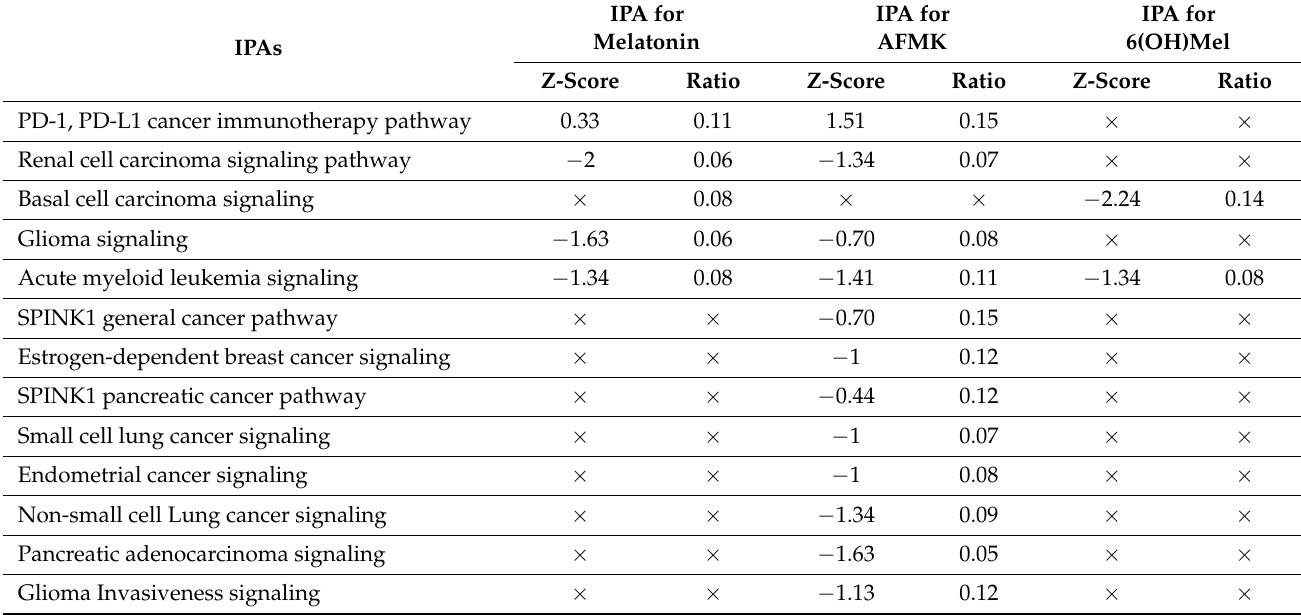
Table 6. Indications for protective effects of melatonin, AFMK and 6(OH)Mel against common human tumors based on Canonical Ingenuity Pathway Analysis (IPA) of data obtained from primary human epidermal keratinocytes. ( × )—the effect is